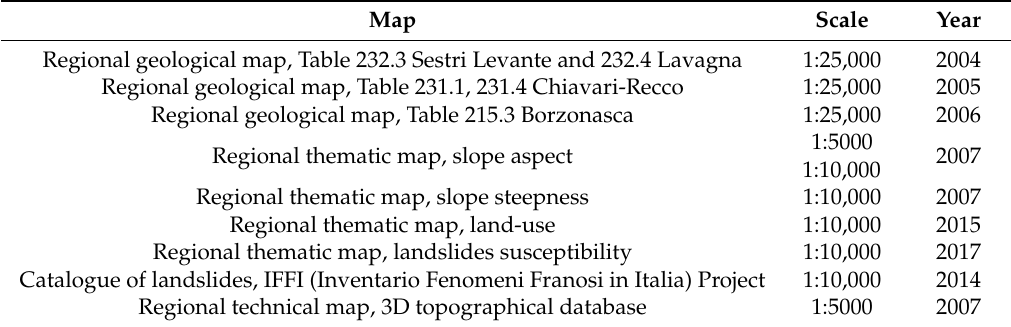
Table 1. Overview of the regional maps used for the Entella basin’s analysis. Map Scale Year Regional geological map, Table 232.3 Sestri Levante and 232.4